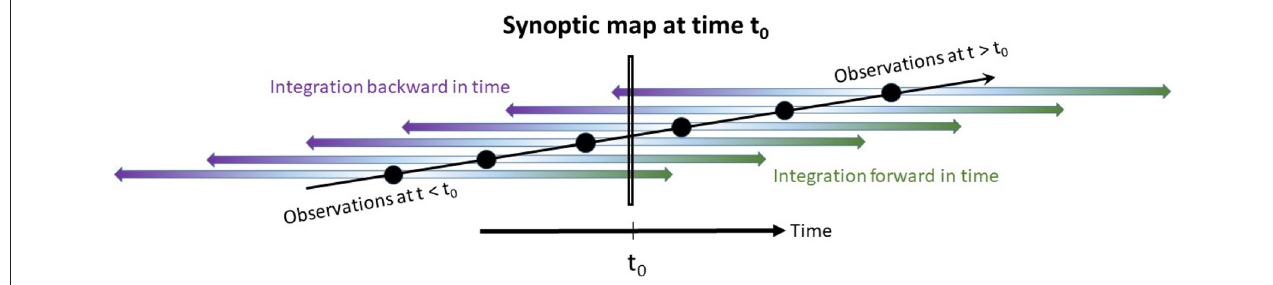
FIGURE 2 | A sketch of how a synoptic plot is generated, assembling snapshots from different trajectories initialized at different times (when corresponding observations were taken) and integrated both backward and forward in time. The vertical coordinate in the graph has no physical meaning, it was introduced to avoid trajectories attached to different observations being plotted on top of each